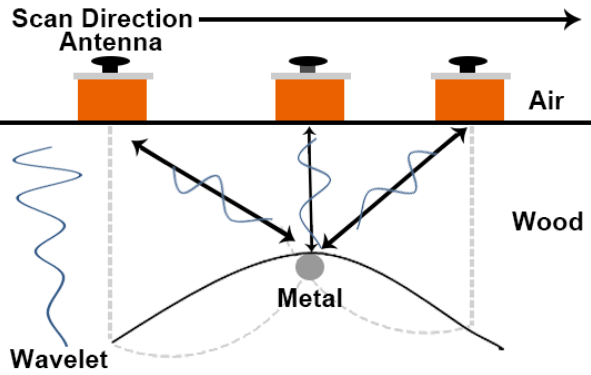
Figure 1. The setting of an antenna position and a target position.